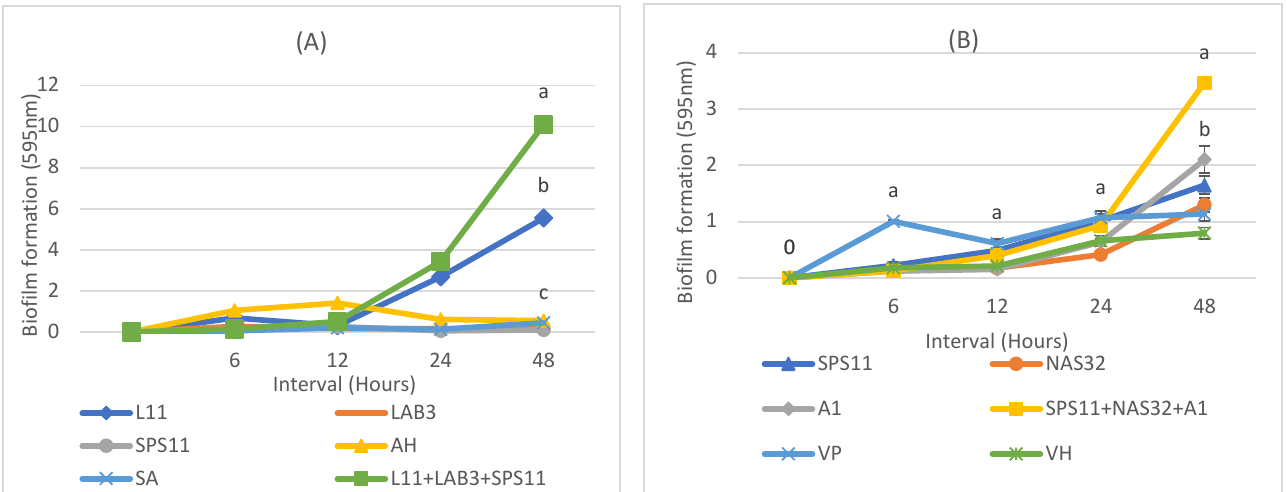
Figure 3. ( A ) Comparison of biofilm formation for SSPs (L11, LAB3, and SPS11) and MSP1 (L11 + LAB3 + SPS11) with A. hydrophila and S. agalactiae . ( B ) Comparison of biofilm formation for SSP (SPS11, NAS32, and A1), MSP (SPS11 + NAS32 + A1) with pathogen V. parahaemolyticus and V. harveyi . Biofilm formation was measured at intervals of 6, 12, 24, and 48 h. Different alphabets indicate significant differences among treatments ( p < 0.05). Table 3. Biofilm-forming ability of SSPs, pathogens and MSP1 at different time interval.